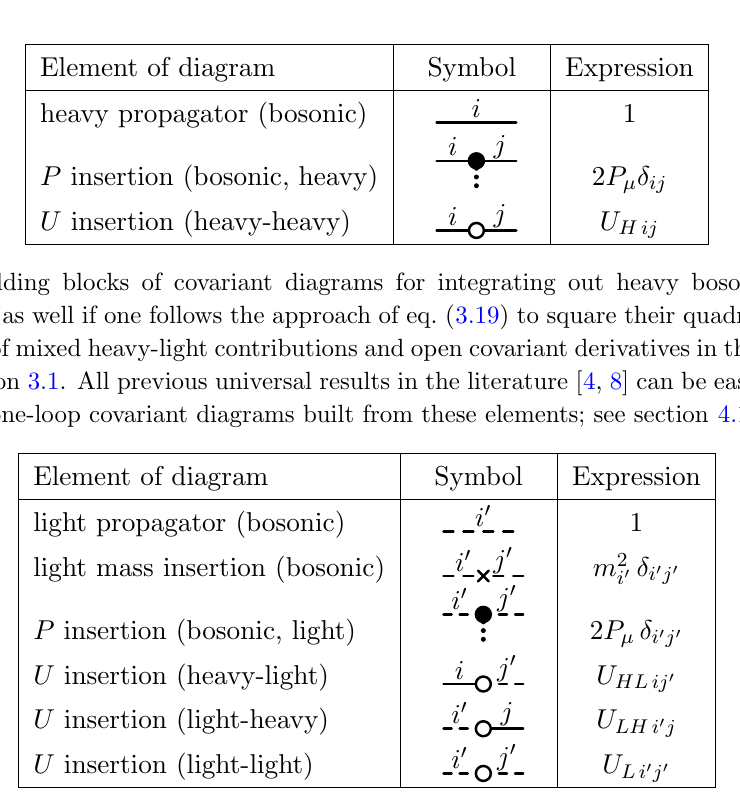
Table 2 . Additional building blocks of covariant diagrams in the presence of mixed heavy-light contributions to matching, as derived in section 3.2. Example applications can be found in sec- tions 4.2, 4.3 and